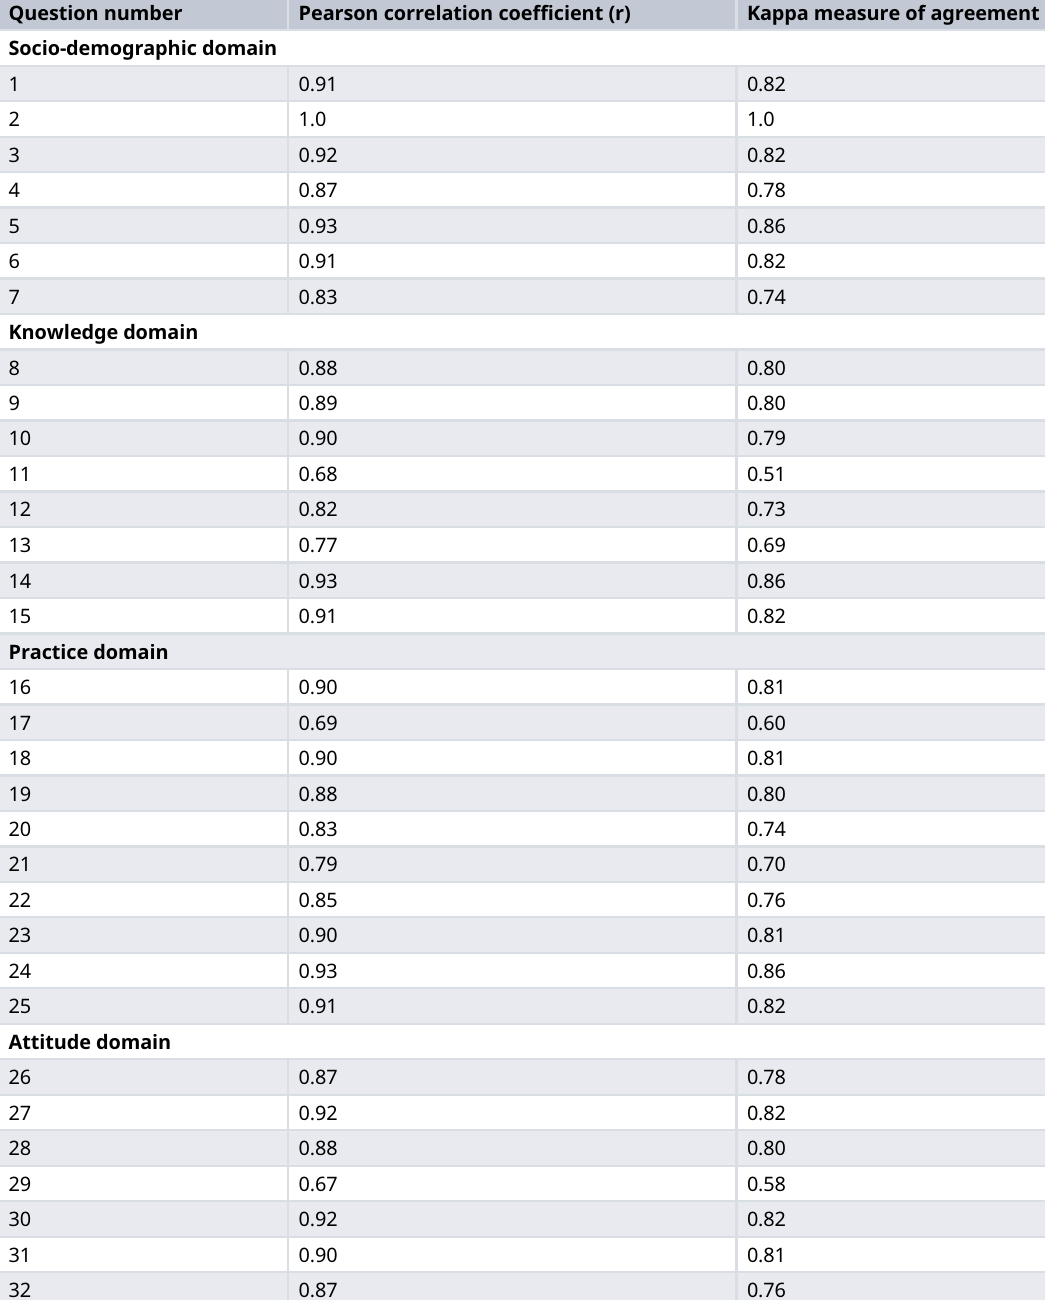
Table 3. Test-retest reliability of knowledge attitude and practice domain items (n =